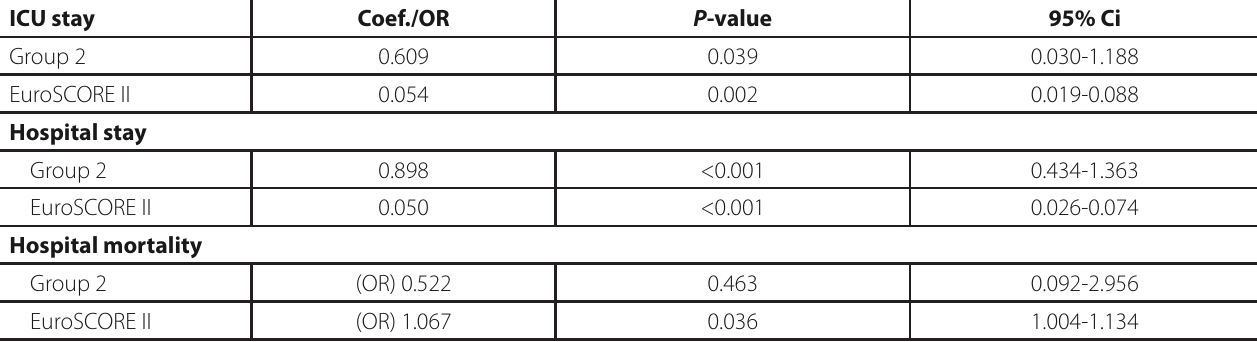
Table 4. Predictors of hospital and ICU stay (negative binomial regression with reporting coefficient) and hospital mortality (logistic regression with reporting odds ratio) (Hosmer-Lemeshow P =0.626; area under the ROC curve=0.706).